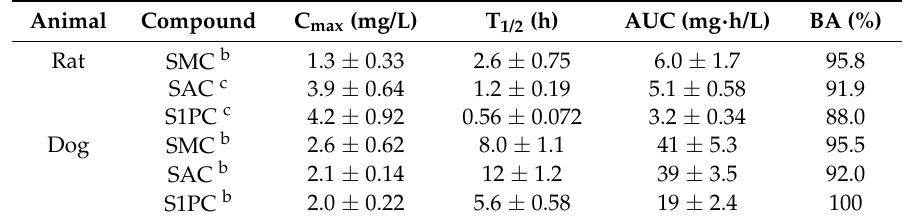
Table 2. Pharmacokinetic parameters and excretion levels of SMC, SAC, and S1PC in rats and dogs after oral administration.